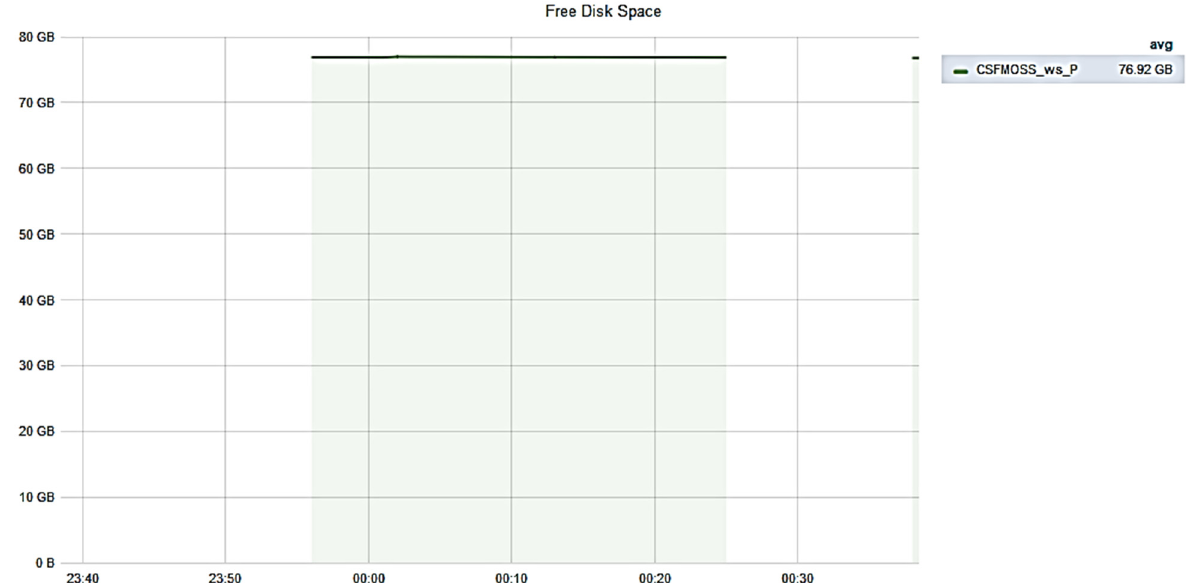
Figure 9: Alert free disk space email